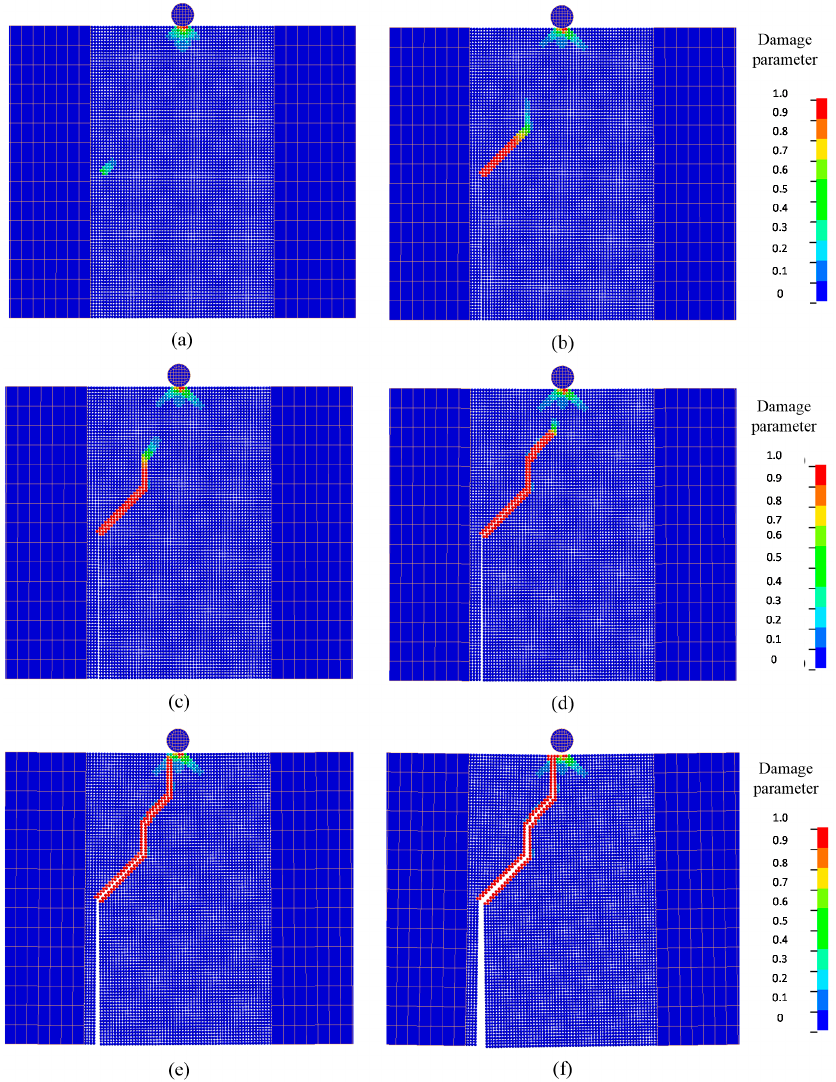
Fig. 32 Figure 32. Evolutions of crack and damage in the concrete beam with an initial offset notch: ( a ) t = 0.15 ms; ( b ) t = 0.24 ms; ( c ) t = 0.28 ms; ( d ) t = 0.37 ms; ( e ) t = 0.57 ms; ( f ) t = 0.99